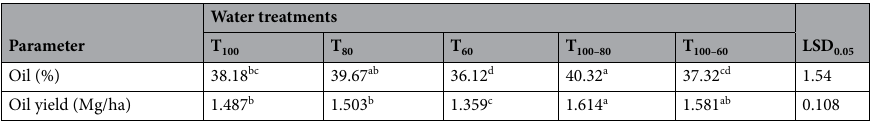
Table 5. Effect of water stress on seed oil content and yield of sunflower. Means followed by the same letter are not significantly different from one another based on LSD at P ≤ 0.05.